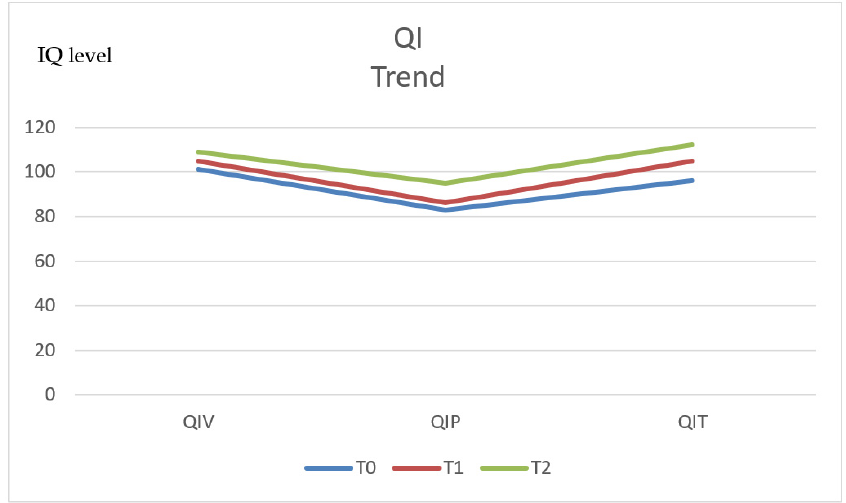
Figure 2. IQ trend.